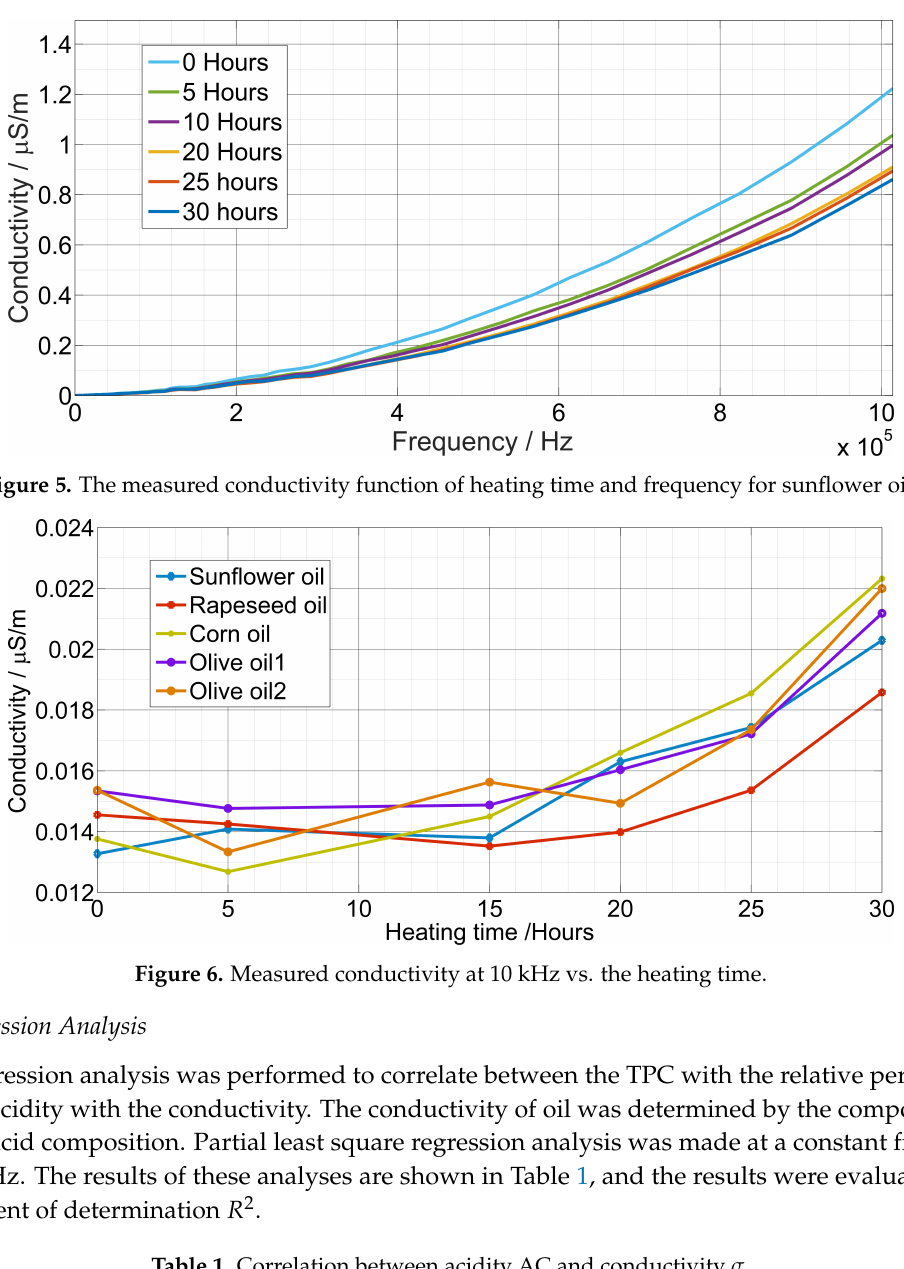
Table 1. Correlation between acidity AC and conductivity σ